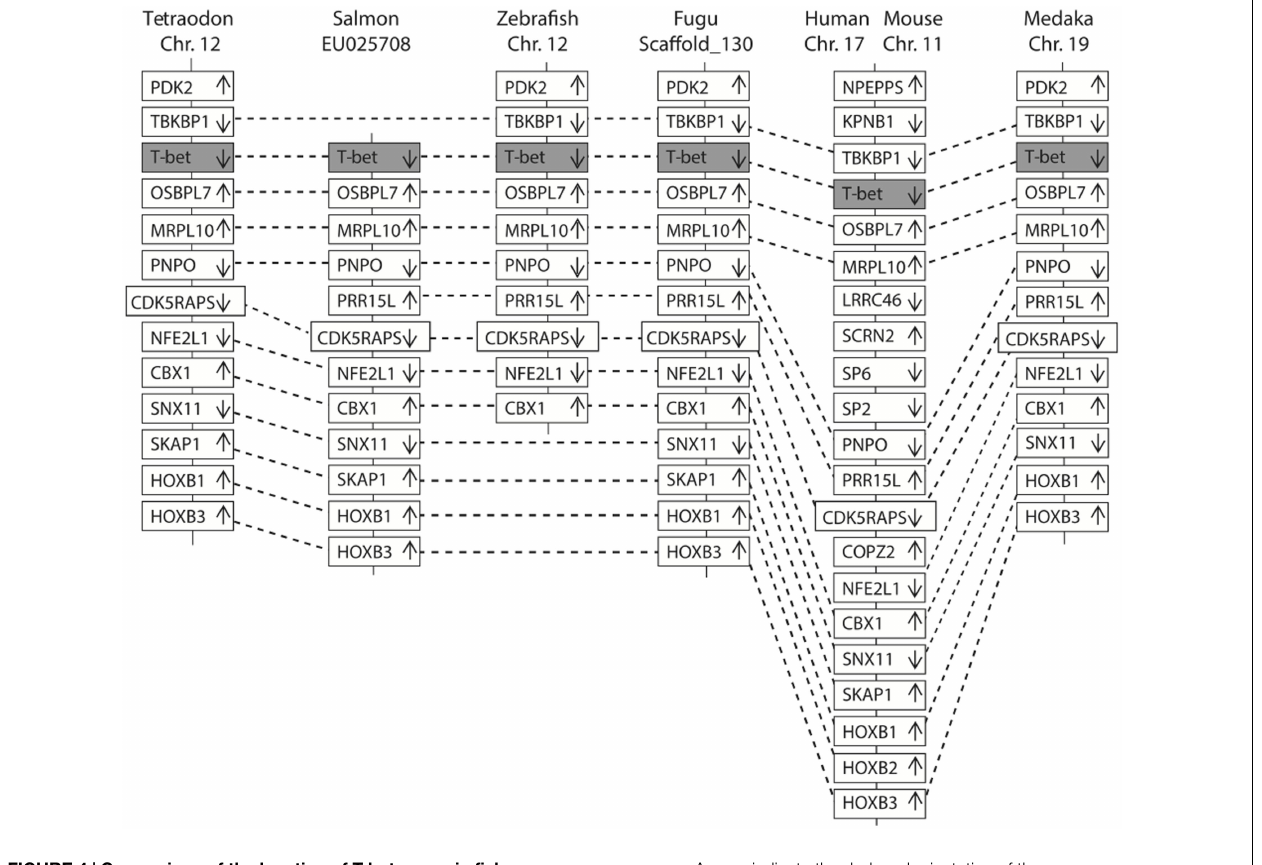
genes. Arrows indicate the deduced orientation of the gene transcription. Dash lines connecting boxes suggest the homologous